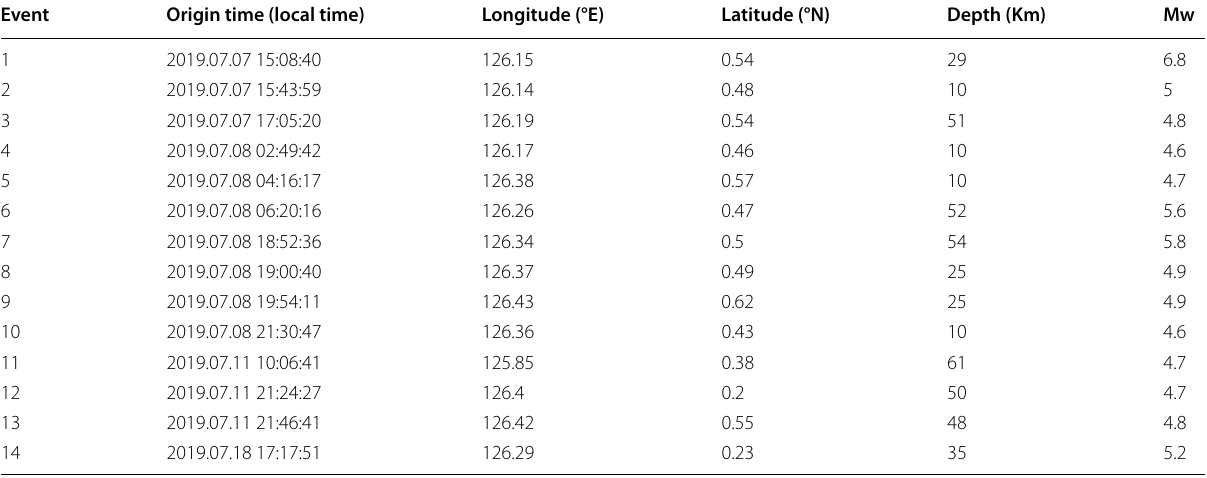
Table 1 Earthquake data from the GFZ catalog used for the moment tensor